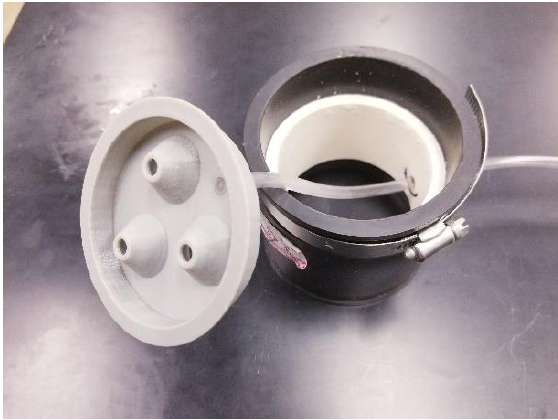
Figure 2. The flow-reduction cap was designed in Autodesk ® Inventor ® to limit the 1 gph flowrate of the mist nozzle to near the desired 2.934 mL min − 1 rainfall rate, assist in rainfall simulation, and separate contaminated soil from the mist nozzle. The three raised holes prevent standing water in the cap from entering the soil column and allow water from the mist nozzle to continue downwards towards the soil column. The single hole in the flat basin of the cap connects to a vinyl discharge tube that removes standing water as it accumulates in the cap.